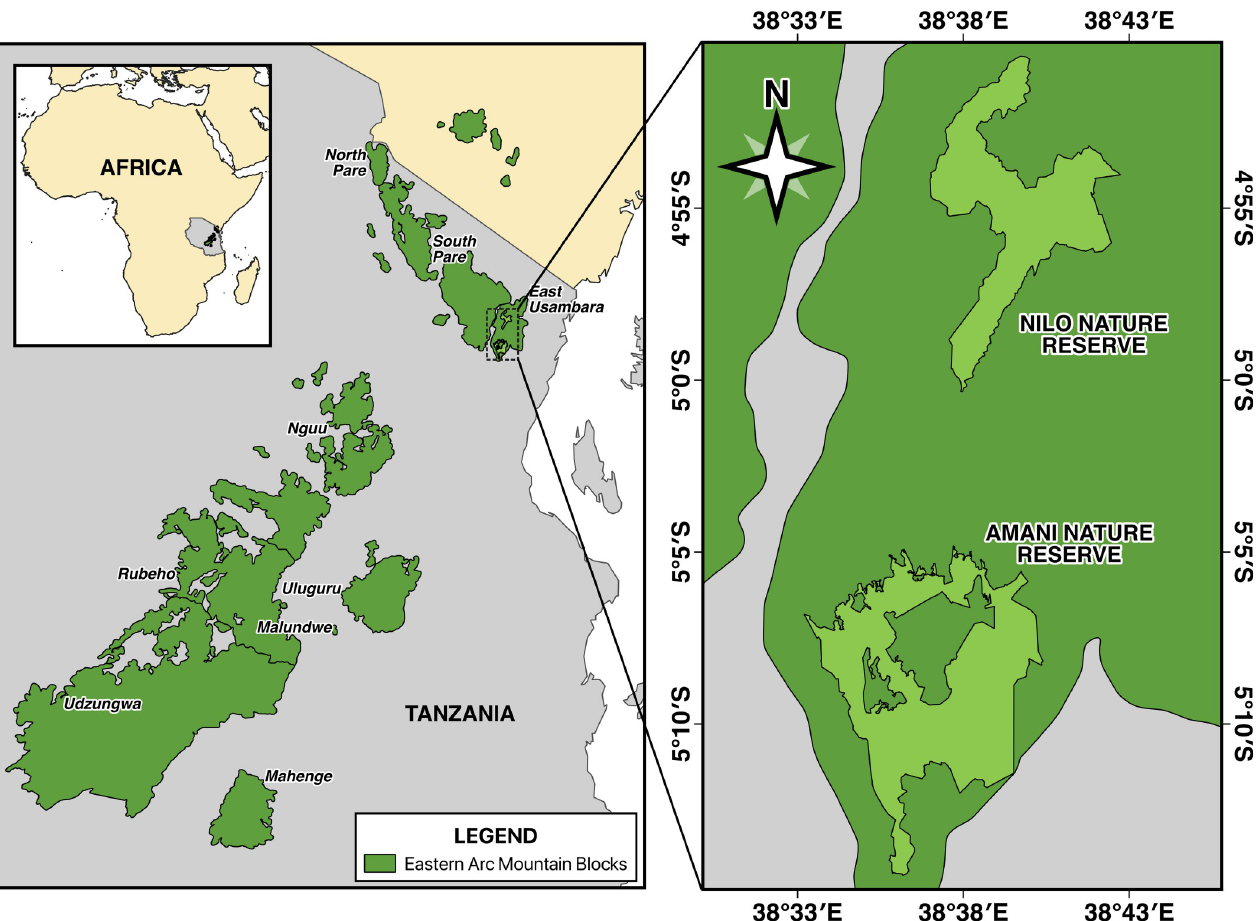
Fig 1. Map of the study area showing Eastern Arc mountains, Amani and Nilo nature forest reserve sites. The Eastern Arc layer source is from [35].